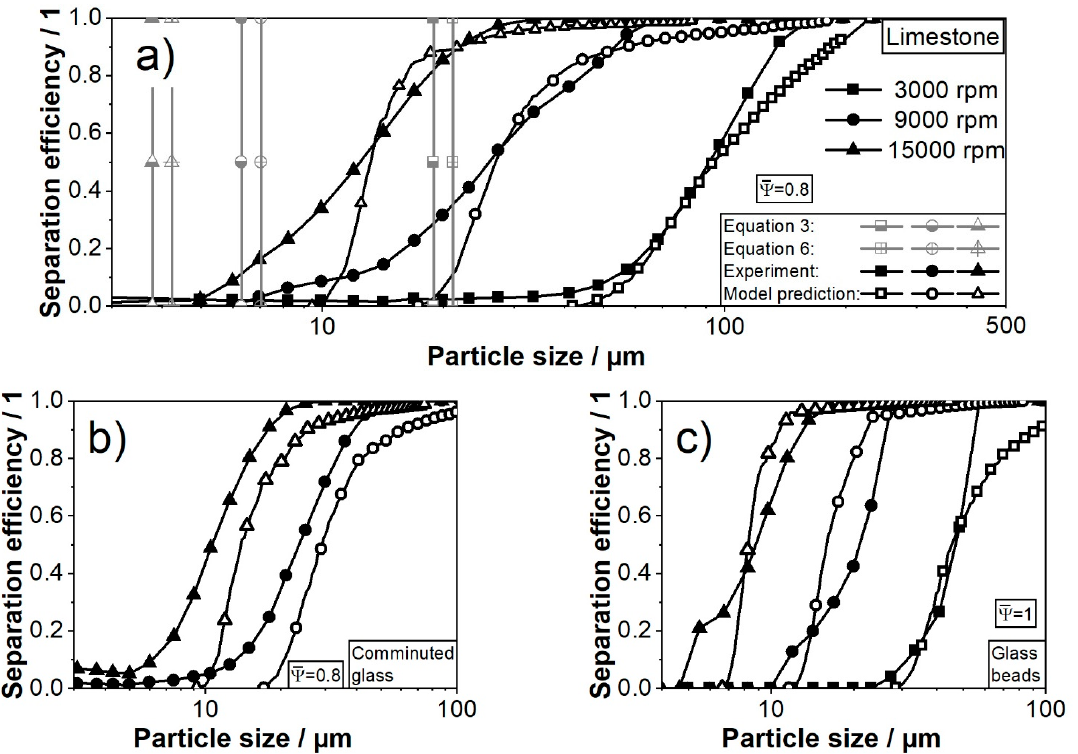
Figure 13. Experimentally measured separation curves versus the cut particle size calculated using Equations (3) and (6) and model predictions using the number of contacts (Figure 10) from DEM simulations. ( a ) is for limestone with ψ as used in 2D sphericity for the calculations; ( b ) shows the result for comminuted glass and ( c ) for glass beads.